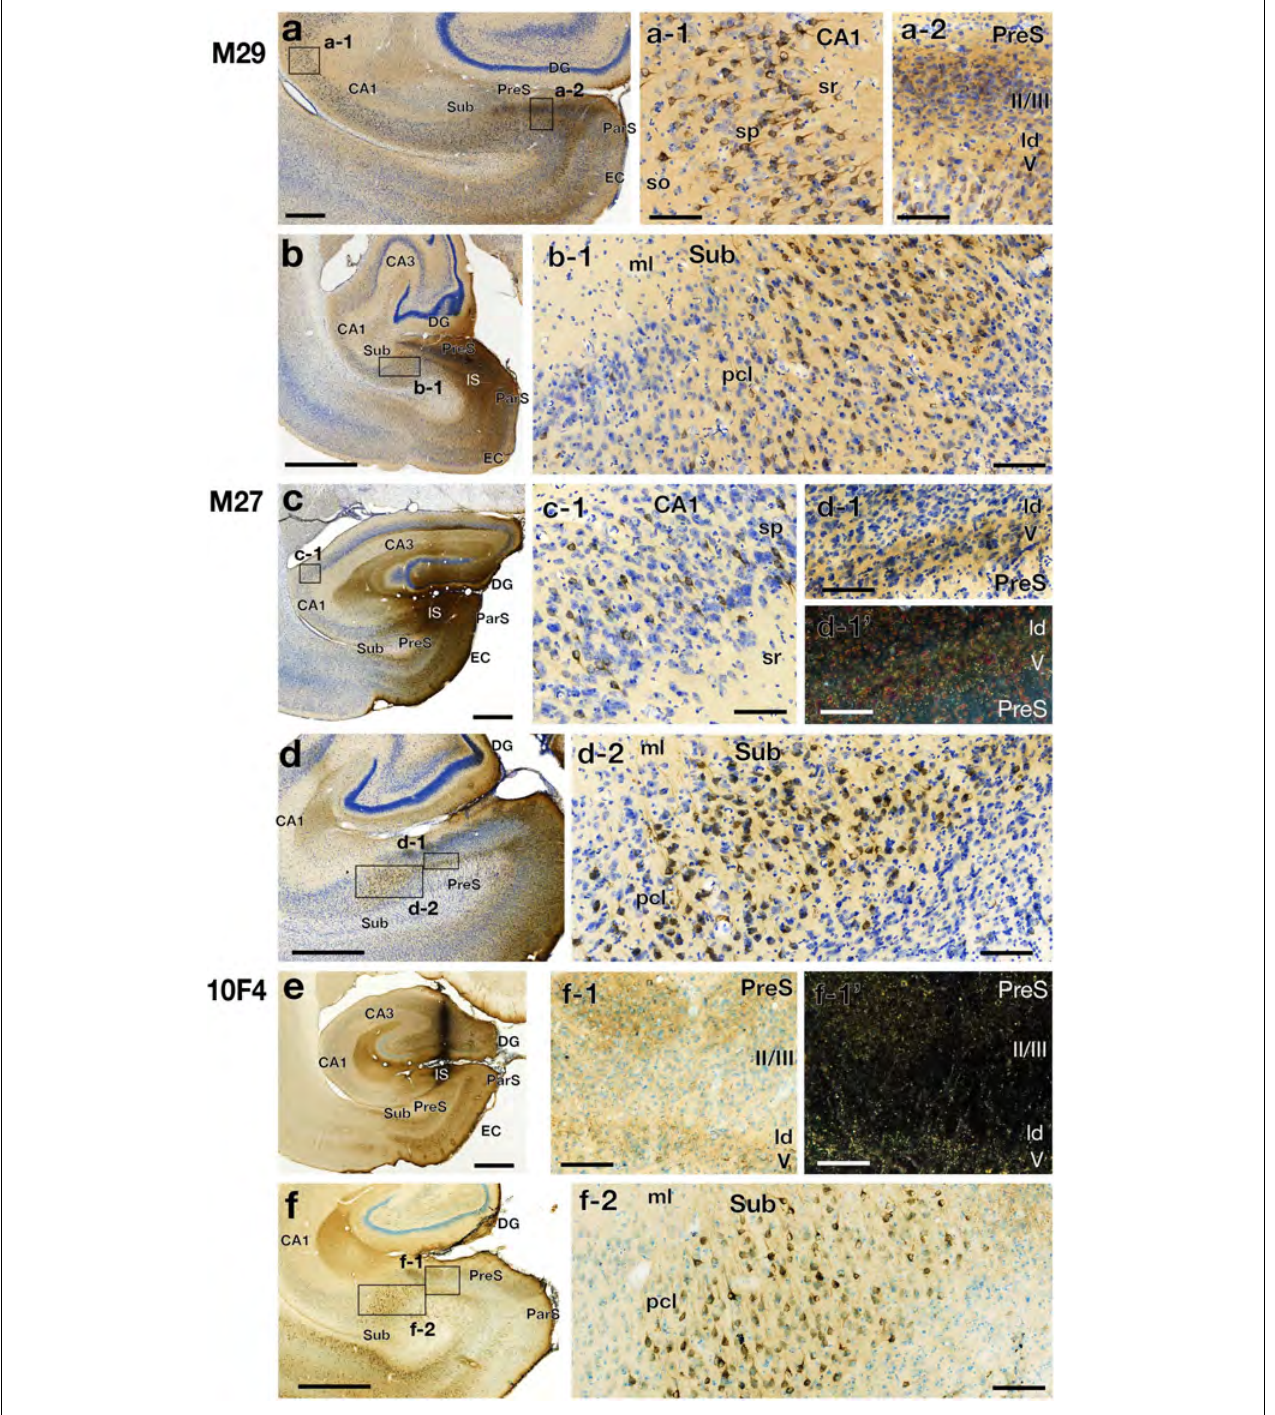
FIGURE 4 | Photomicrographs of the hippocampal and parahippocampal areas in three CTB injection cases (cases M29, M27, and 10F4) on the same side of the injection (left hemisphere). High-magnification images of rectangles in each panel of the left row (a, b, c, d, and f) are shown in the middle and right rows. Panels d-1’ and f-1’ are dark-field images of the same section as d-1 and f-1, respectively. Scale bar = 1 mm in the left row (a-f) and 100 µ m in the other panels. CA, cornu ammonis; DG, dentate gyrus; EC, entorhinal cortex; IS, injection site; ld, lamina dissecans; ml, molecular layer; ParS, parasubiculum; pcl, pyramidal cell layer; PreS, presubiculum; so, stratum oriens; sp, stratum pyramidale; sr, stratum radiatum; Sub, subiculum. Note that the labeled CA1 cells were diffusely distributed in the pyramidal cell layer. Note also that, in Sub, labeled cells were densely distributed in the middle part of the pyramidal cell layer, while very few in superficial and deep parts. In PreS, many anterograde labels were observed in layers I, II, and V along with ld.